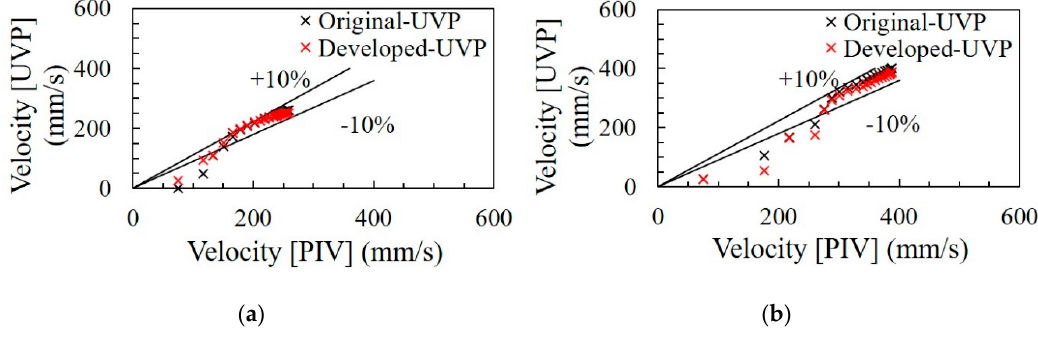
Figure 12. Discrepancy for the single ‐ phase liquid velocity profile: ( a ) U L = 200 mm/s and ( b ) U L = 300 mm/s.